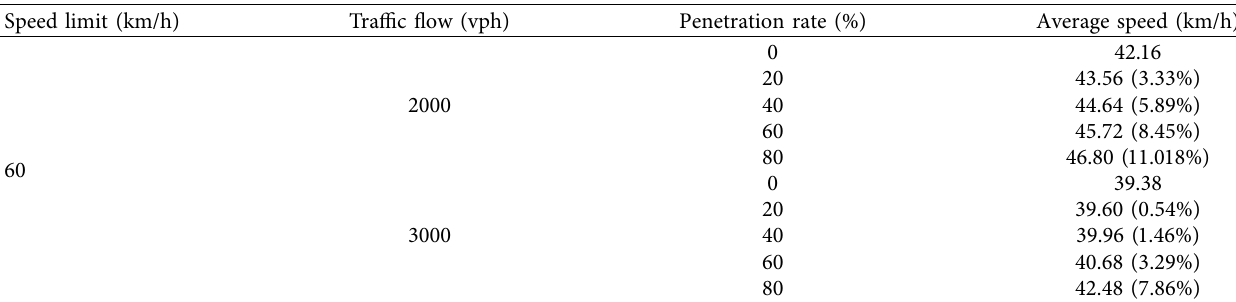
Figure 17: Overall performance of different penetration rates. (a) Speed limit of 60km/h. (b) Speed limit of 80km/h. (c) Speed limit of 110km/h. Table 4: Overall performance of different penetration